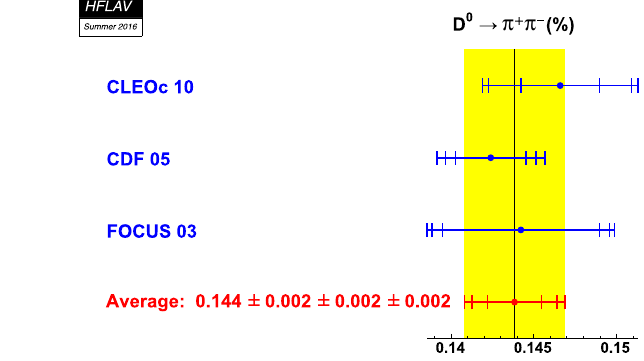
The B ( D 0 → K − π + ) average obtained here is approx-